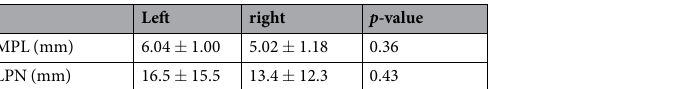
Table 2. Comparison between the sides (n = 34) MPN = medial plantar nerve LPN = lateral plantar nerve The p-values were determined using paired sample t-tests. Significance levels are indicated by p <